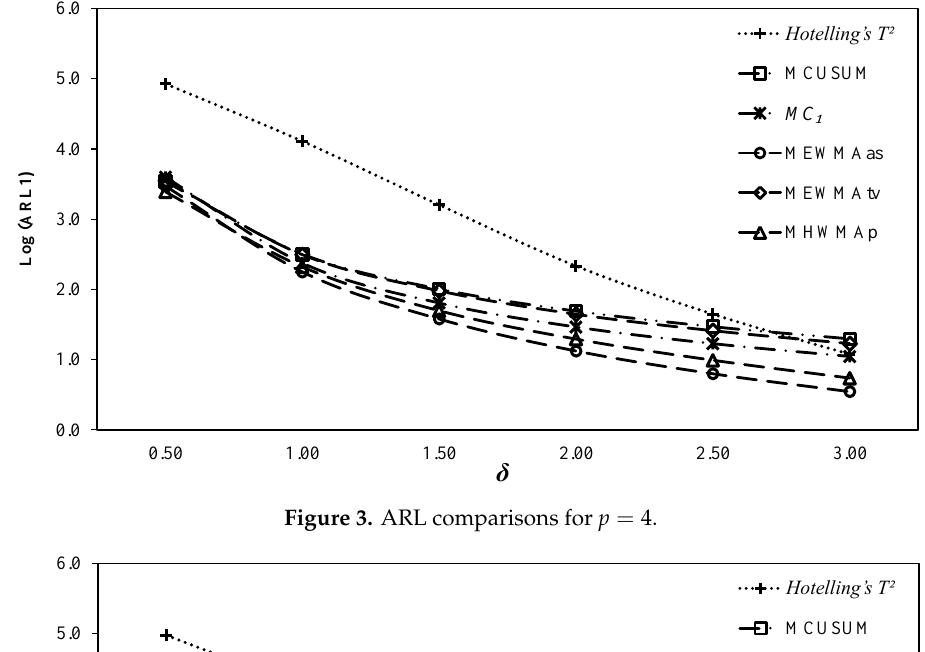
Figure 3. ARL comparisons for 𝑝 = 4 .